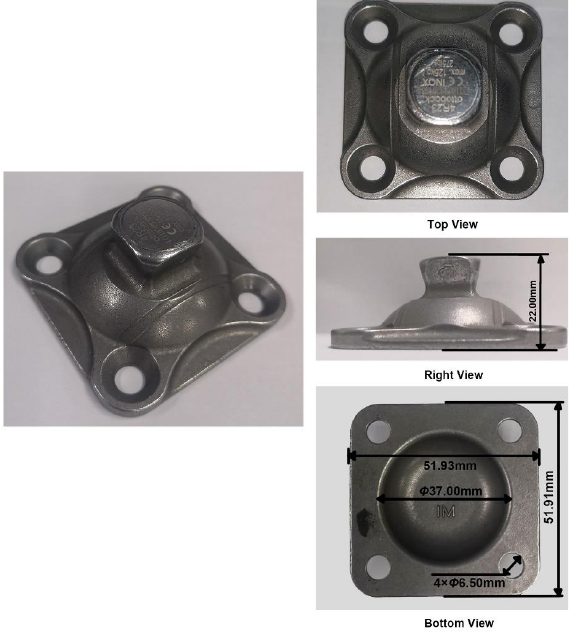
Figure 5. Different views of the 4R23 adaptor.